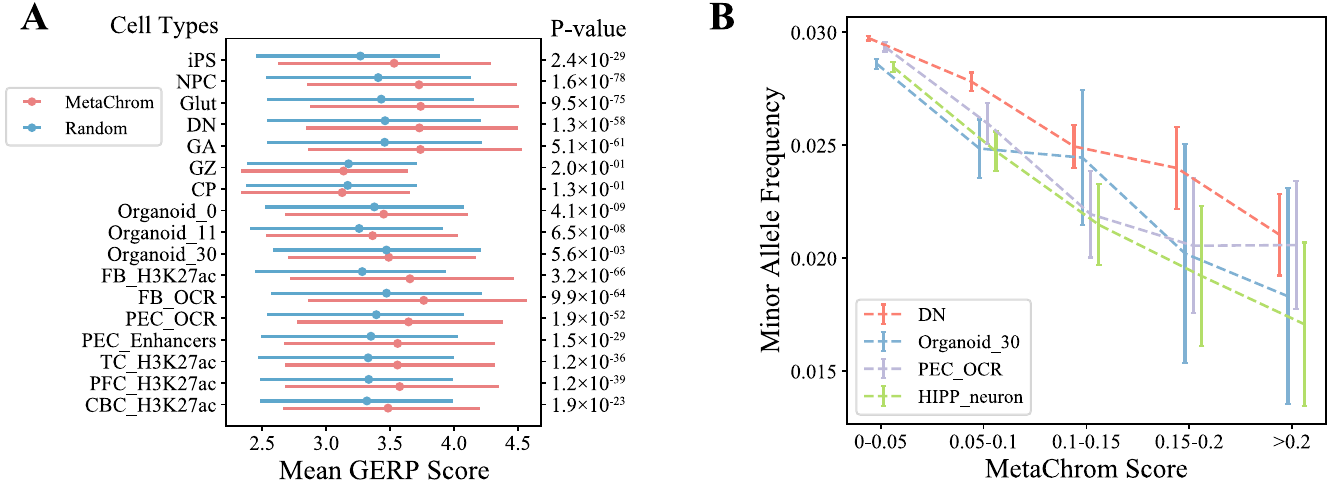
Fig 3. Validation of MetaChrom predicted functional variants with evolutionary constraint. (A) Distribution of GERP scores between MetaChrom predicted functional variants and random variants. (B) Minor allele frequencies of variants defined by MetaChrom scores in four selected cell types. Only variants inside peak regions of the epigenomic data were